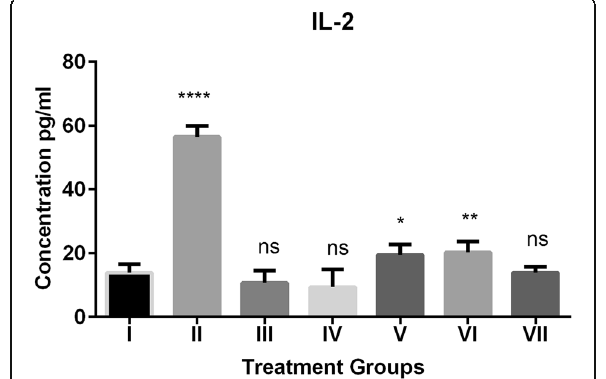
Fig. 2 Effect of grapefruit juice (GFJ) and aripiprazole (ARI) on oxidative stress induced by H 2 O 2 by IL-1 α levels. IL-1 α concentration is expressed as pg/ml ( n = 10); The treated groups were compared to control group. **** P < 0.0001, ** P < 0.01, ns: non-significant. # Group I: Control; Group II: H2O2 treated; Group III; ARI treated; Group IV GFJ treated; Group V: GFJ and H 2 O 2 treated; Group VI; ARI and H 2 O 2 treated; Group VII; ARI, GFJ and H 2 O 2 treated